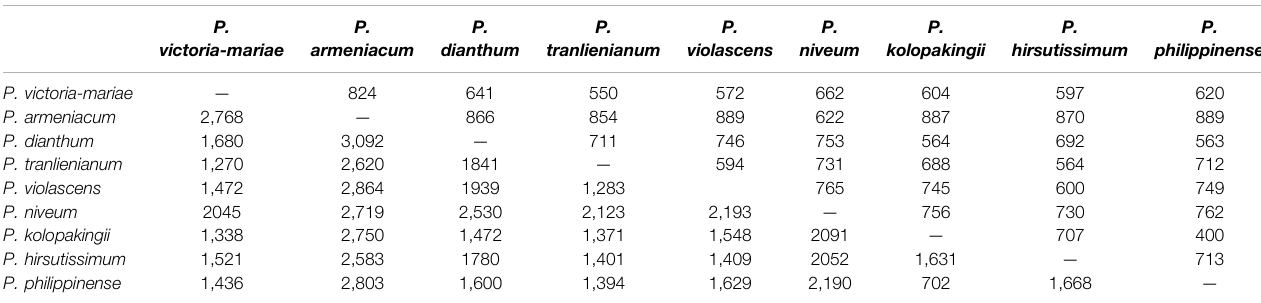
TABLE 4 | Number of insertions/deletions (indels) and nucleotide substitutions in the nine Paphiopedilum chloroplast genomes